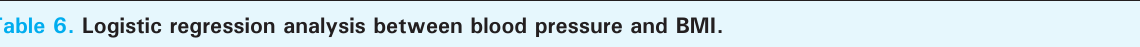
Table 6. Logistic regression analysis between blood pressure and BMI. BMI Systolic BP Diastolic BP Normal and high Normal and high AOR 95% CI P value AOR 95% CI P value Normal 1 1 Underweight .616 .213-1.78 0.371 .566 0.24-1.30 .18 Overweight